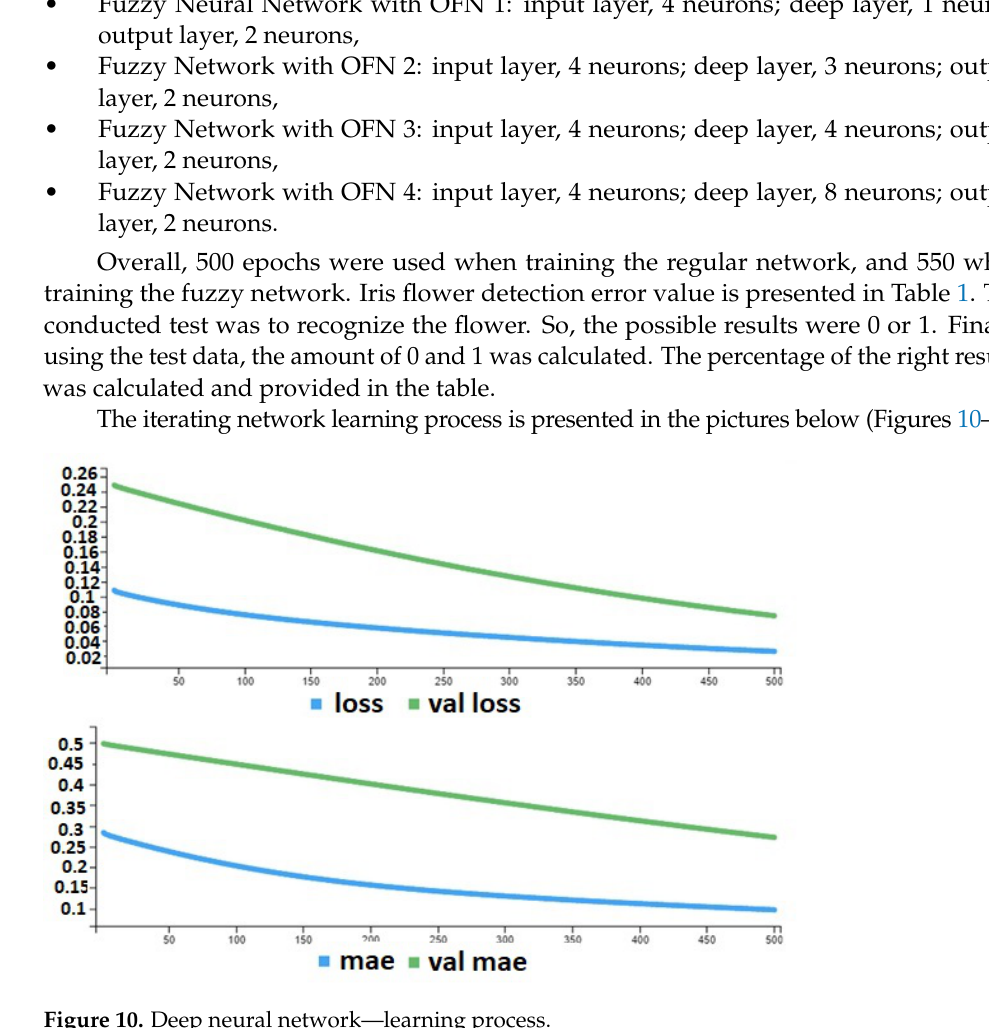
Figure 10. Deep neural network—learning